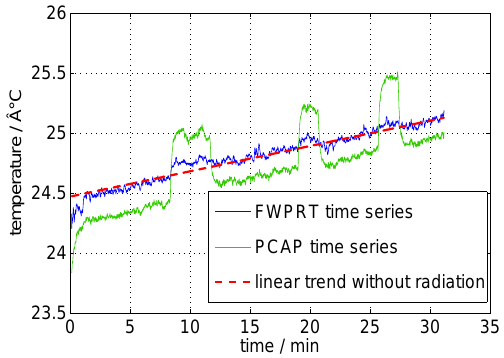
Fig. 13. A time series of a wind tunnel experiment with artificial radiation